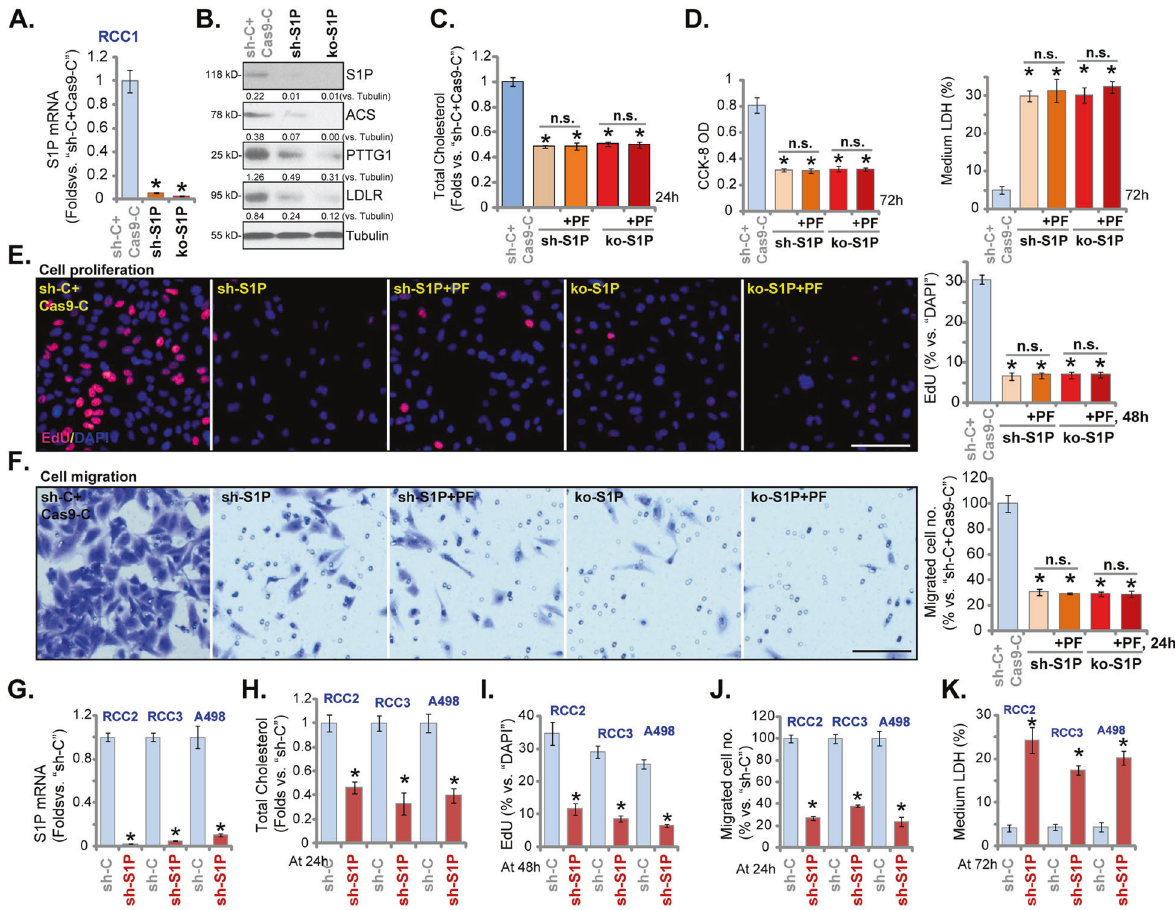
Fig. 3 S1P silencing or knockout inhibits RCC cell growth. Stable RCC1 cells expressing S1P lentiviral shRNA ( “ sh-S1P ” cells) or the CRSPR/ Cas9-S1P-KO-GFP construct ( “ ko-S1P ” cells) were established, control cells were transduced with scrambled control shRNA plus CRSPR/Cas9 empty vector ( “ sh-C + Cas9-C ” ); Expression of listed genes was shown ( A and B ); Cells were then treated with or without PF-429242 (10 μ M), and cultured for applied time periods, total cholesterol levels were tested ( C ); Viable cell number, cell death, proliferation, and migration were tested by CCK-8 ( D ), LDH release ( D ), nuclear EdU staining ( E ) and “ Transwell ” ( F ) assays, respectively, and results were quanti fi ed.RCC2, RCC3, and A498 cells, expressing S1P lentiviral shRNA ( “ sh-S1P ” cells) or scramble control shRNA ( “ sh-C ” ), were established and S1P mRNA expression was shown ( G ); Cells were further cultured for applied time periods, total cholesterol levels were tested ( H ); Cell proliferation, migration, and cell death were tested by nuclear EdU staining ( I ), “ Transwell ” ( J ) and medium LDH release ( K ) assays, respectively. For each assay, n = 5. Data were expressed as the mean ± standard deviation (SD).* P < 0.05 vs. “ sh-C + Cas9-C ” / “ sh-C ” group. “ n.s. ” stands for no statistical difference ( C – F ). In this fi gure, experiments were repeated three times, and similar results were obtained each time. Scale bar = 100 μ m ( E and F ).